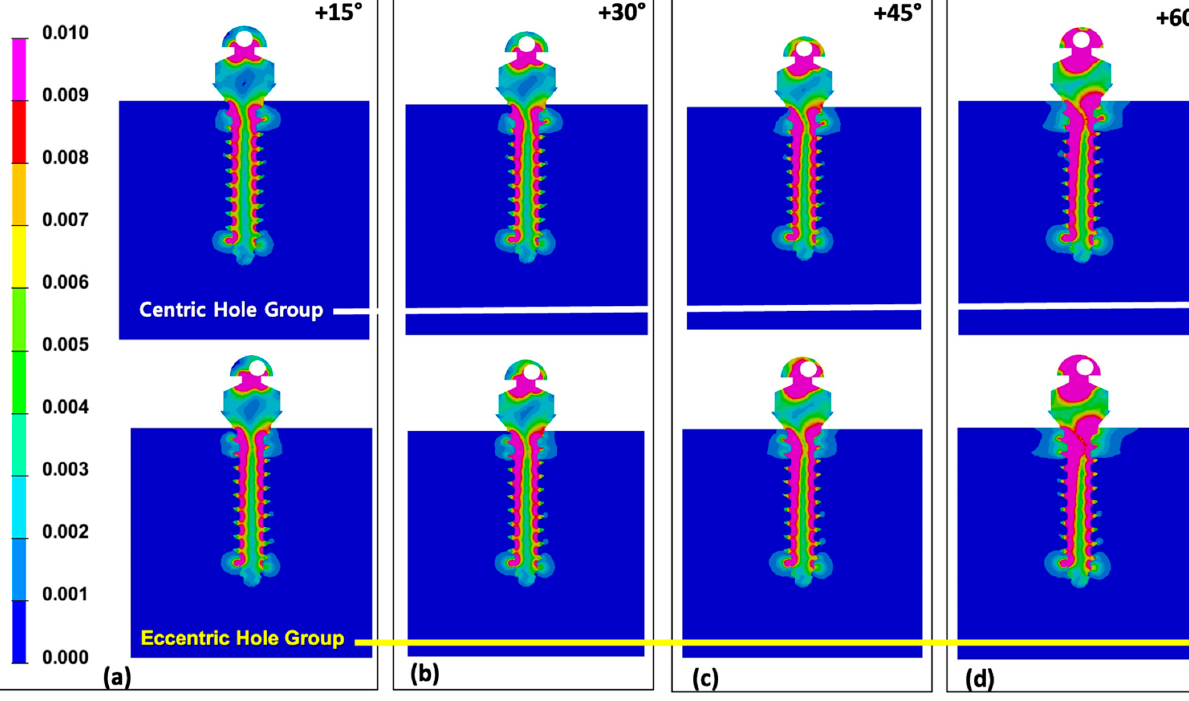
Figure 5. Distribution of Von-Mises stress under the condition of 1 ◦ counter-clockwise rotation of the miniscrew placed with various positive angles on the alveolar bone surface: ( a ) Von-Mises stress distribution of the miniscrew at +15 ◦ angulation in centric and eccentric hole groups; ( b ) Von-Mises stress distribution of the miniscrew at +30 ◦ angulation in centric and eccentric hole groups; ( c ) Von-Mises stress distribution of the miniscrew at +45 ◦ angulation in centric and eccentric hole groups; ( d ) Von-Mises stress distribution of the miniscrew at +60 ◦ angulation in centric and eccentric hole groups. In both groups, more stress was concentrated on the upper 1/3 as the angle increased.